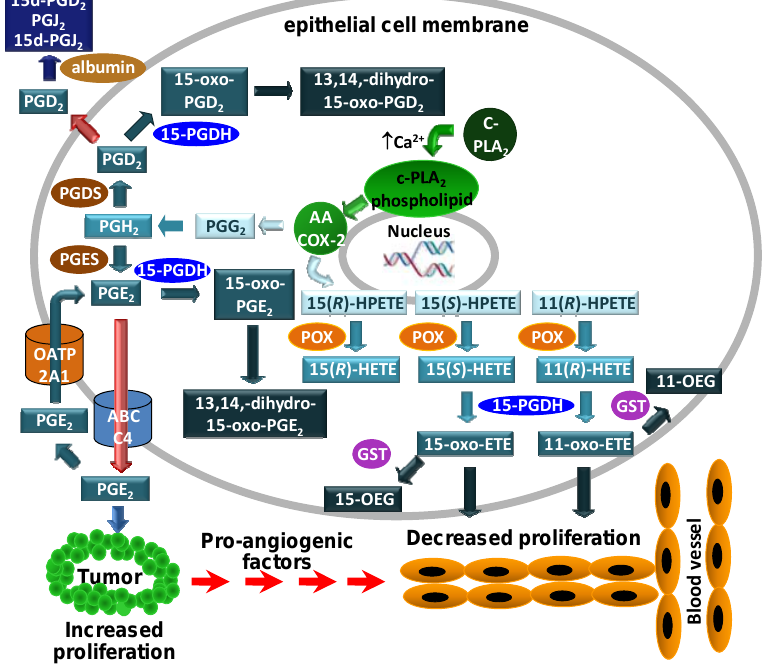
Figure 3. Formation and action of COX-2-derived eicosanoids in epithelial cell models. arachidonic acid is released from membrane phospholipids by calcium-dependent cytosolic phospholipase A (cPLA ). The released arachidonic acid undergoes COX-2-mediated 2 2 metabolism to PGs or forms the lipid hydroperoxides, 15( S )-hydroperoxyeicosatetraenoic acid (HPETE), 15( R )-HPETE and 11( R )-HPETE, which are reduced to the corresponding HETEs. PGD and PGE are inactivated by 15-PGDH-mediated conversion to their 15-oxo 2 2 metabolites. Both 15-oxo-PGD and 15-oxo-PGE are converted to 13,14-dihydro-5-oxo- 2 2 PG metabolites. Intact PGD secreted by the epithelial cells can undergo albumin-mediated 2 dehydration to 15d-PGJ . PGE secreted from the epithelial cells by the ABCC4 transporter 2 2 is pro-proliferative for tumor cells. Reuptake of PGE by OATP2A1 into the epithelial cells 2 leads to further 15-PGDH-mediated inactivation. In contrast to PGE and PGD , 15( S )- 2 2 HETE and 11( R )-HETE are activated by 15-PGDH-mediated oxidation to 15-oxo-ETE and 11-oxo-ETE, respectively. The oxo-ETEs are further conjugated to form OEGs. Secreted 15- and 11-oxo-ETE that escape further metabolism can then inhibit endothelial cell proliferation. Therefore, down-regulation of 15-PGDH and OATP2A1 would result in increased PGE -mediated tumor and endothelial cell proliferation. Reprinted with 2 permission from Ref